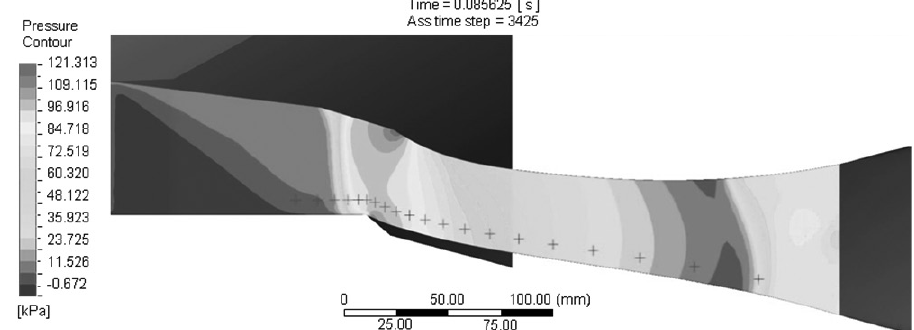
the physical submodel